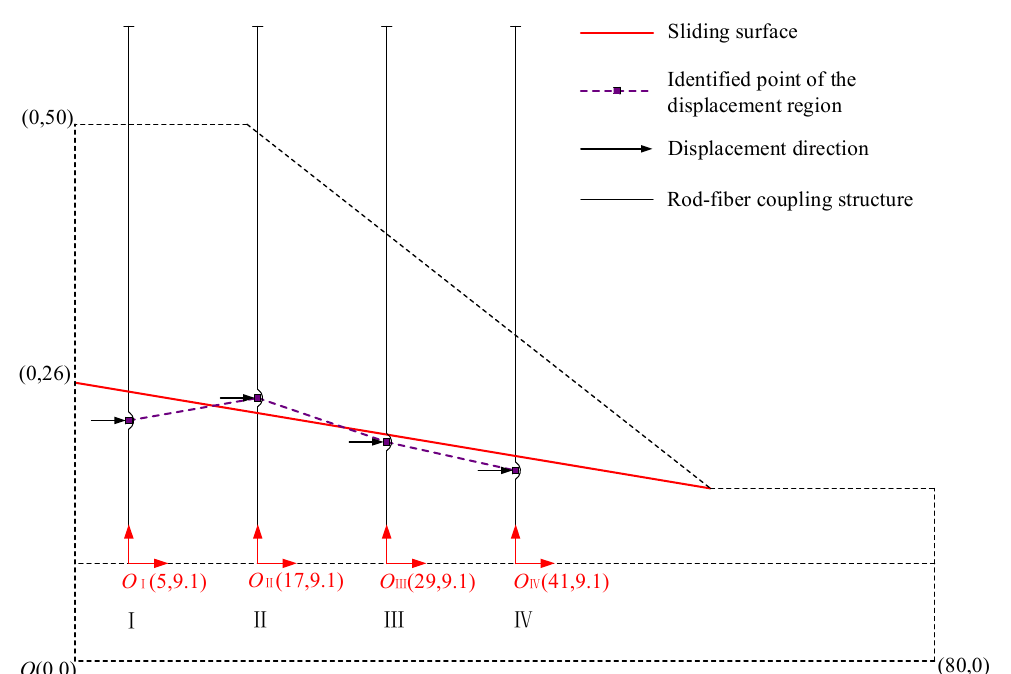
Figure 18 . Sliding surface according to the identified point of the displacement region (unit: cm).